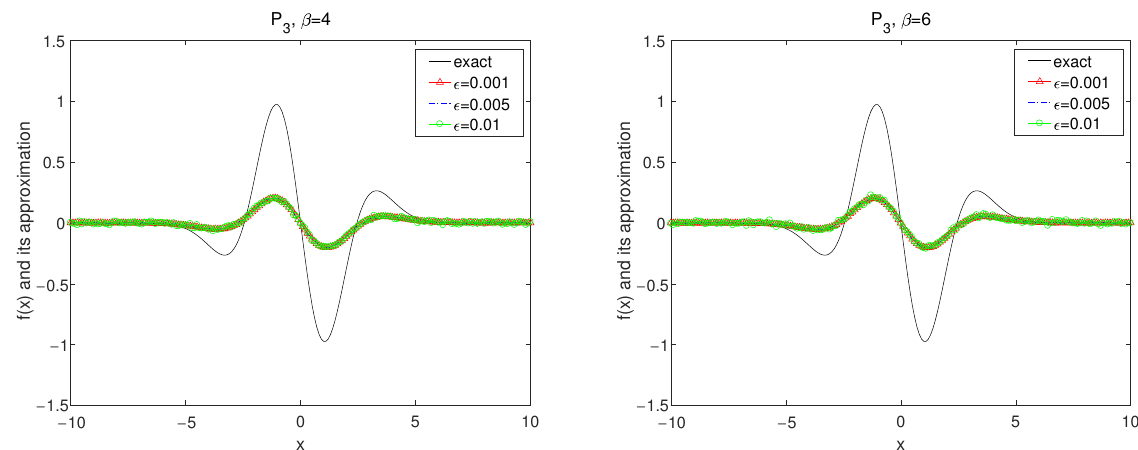
Figure 6. The exact solution and the regularized solutions with β = 4,6 using kernel P 3 under the a posteriori choice rule for Example 1.